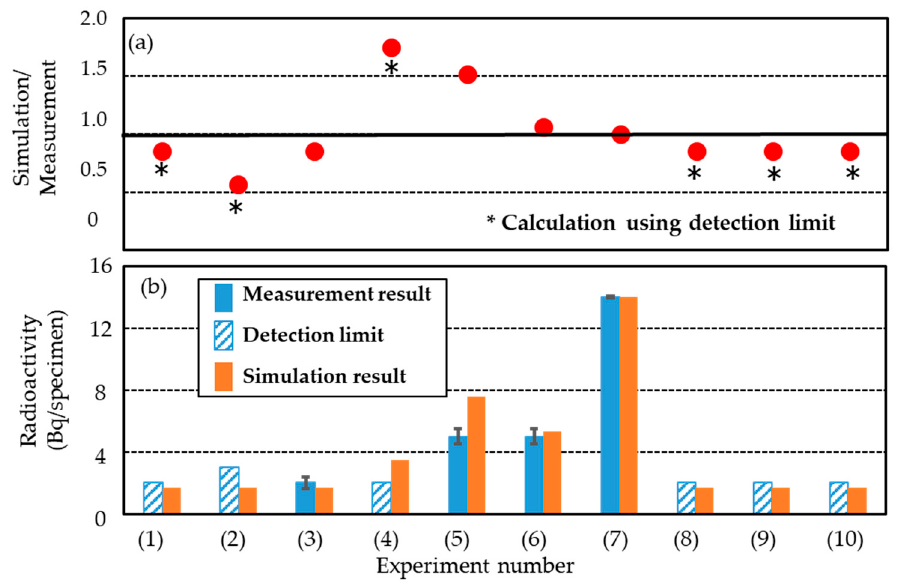
Figure 10. Comparison of measured and simulated 7 Be radioactivities. ( a ) Ratio of simulated radioactivity to the measured value. ( b ) Measured and simulated radioactivities. The 1 σ counting error intervals are shown as error bars in the measurement